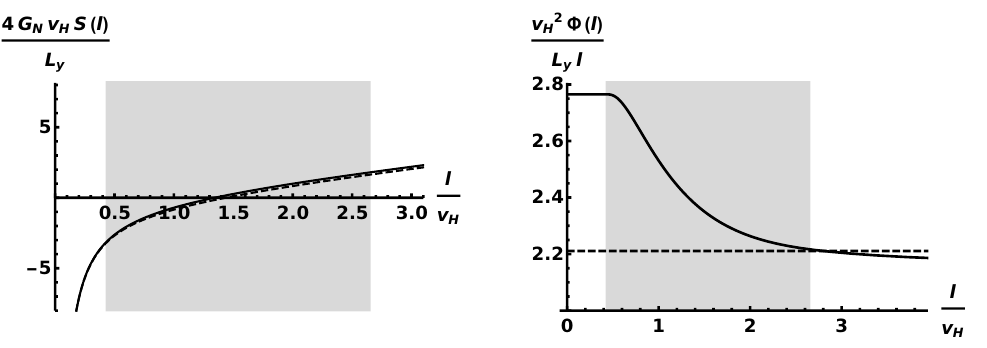
Figure 2 . Left : entanglement entropy for the electron cloud geometry with T/µ = 0 . 02 . The shaded gray area corresponds to the strip widths where the turning point is inside the cloud. In the UV, the entanglement entropy has the expected CFT behavior S ( l ) ∼ l − 1 , while in the IR, it scales as S ( l ) ∼ l . The existence of the cloud can be inferred from the temperature dependence of the multiplicative constant in this latter regime, as is discussed in the text. Right : flux through the strip per unit width. Again the shaded gray area corresponds to the cloud region. It can be seen that when the strip lies outside the cloud (small l/v ) the flux has the expected behavior Φ( l ) ∼ l . H The coefficient of proportionality is directly related to the total charge density of the black hole and cloud. In the IR region, the strip has dropped below the cloud, so the same extensive behavior is recovered, now with a coefficient that counts only the charge originating from the black hole. For the sake of comparison, in both figures we have also shown the results that are obtained in the pure RN case (dashed